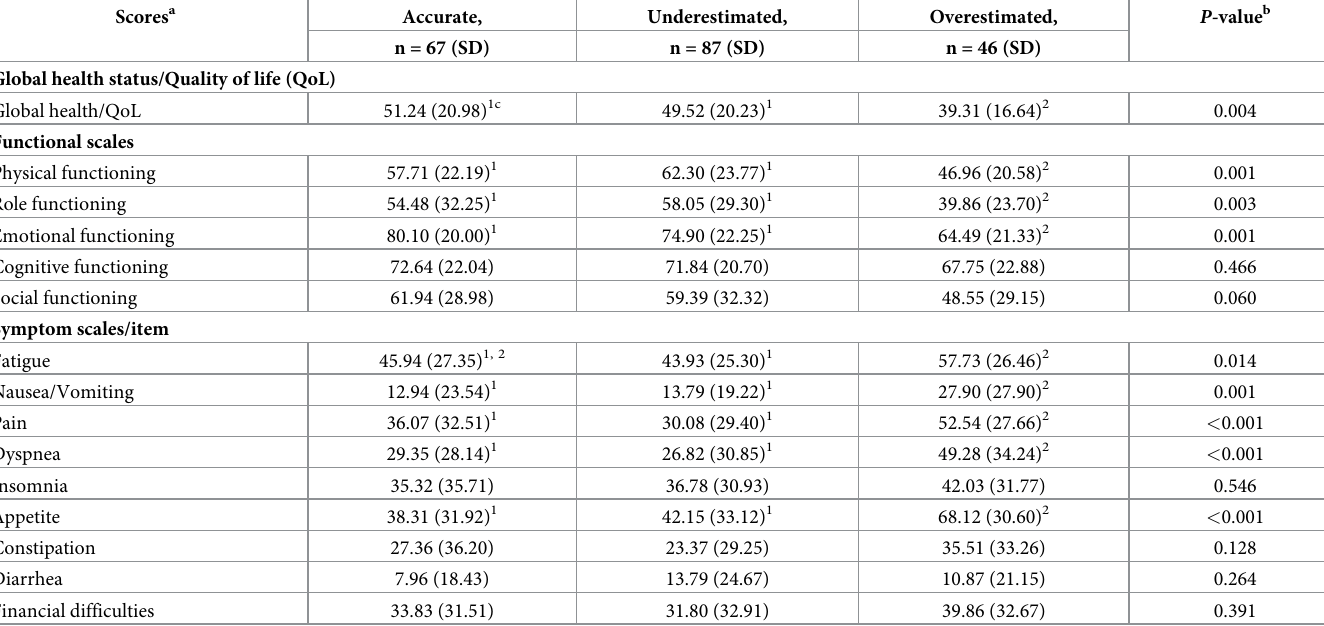
Table 4. Association between the accuracy of clinician prediction of survival and mean EORTC-QLQ-C30 scores. Scores a